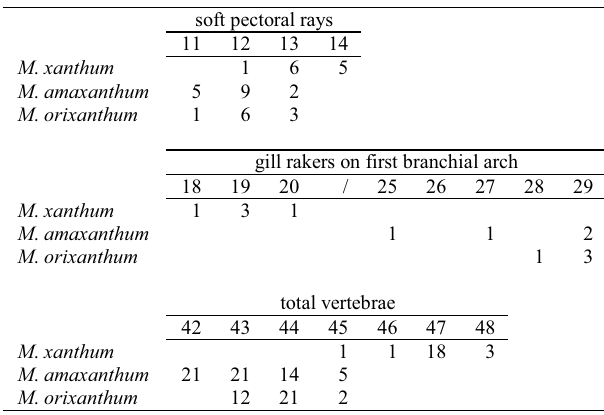
Table 1. Frequency distributions for counts of soft pectoral- fin rays, gill rakers on first branchial arch, and total